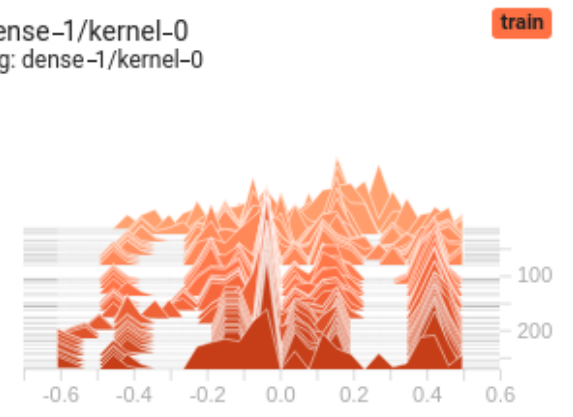
Figure 10. Weights’ histograms over training epochs for the second layer.